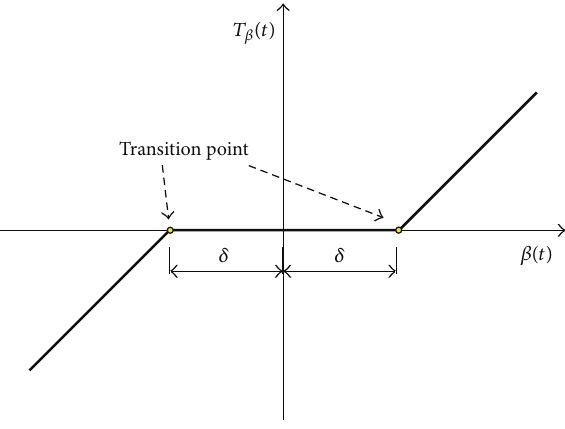
Figure 2: Freeplay